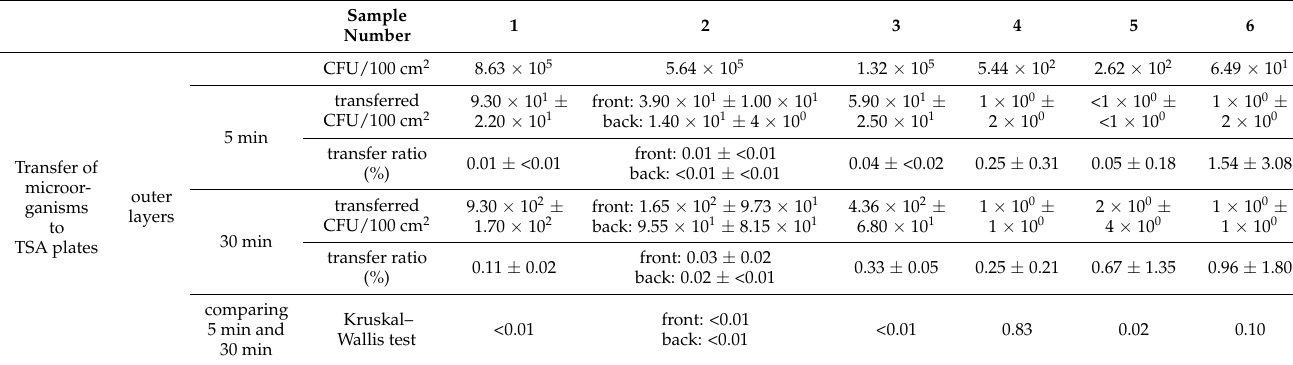
Table 4. Transfer of microorganisms from the packaging material samples to tryptone soy agar (TSA) plates with different tested incubation times. The samples are labeled with respect to their numbers of colony-forming units per 100 square centimeters (CFU/100 cm 2 ) in descending order (1–6). The experimental set-up was performed as described in Figure 2(2). Data are shown as mean ± SD. The transfer ratios are declared as a percentage (%). A p -value of <0.05 was defined as statistically